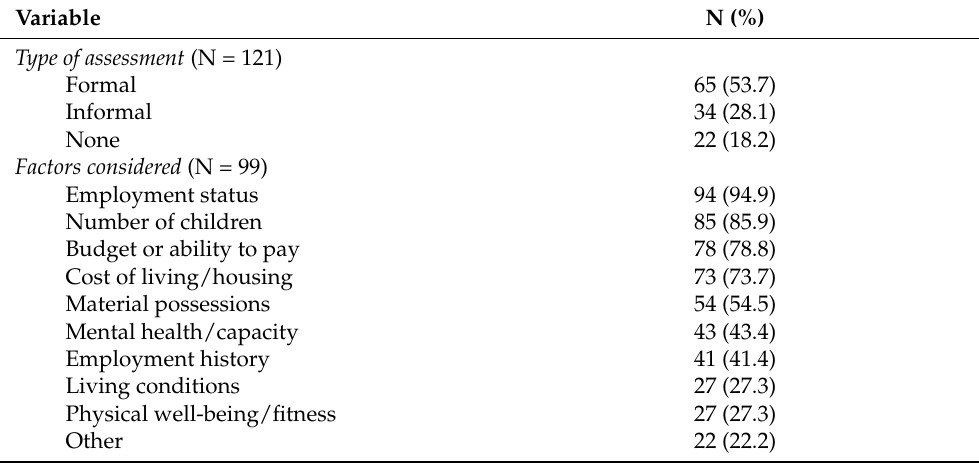
Table 4. Types of assessments conducted to determine ability to pay fees and factors considered during